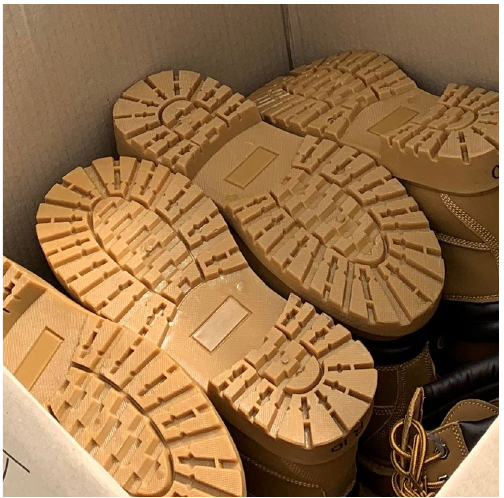
Figure 1. Boots used in the study showing the deep and complex tread pattern of the sole.